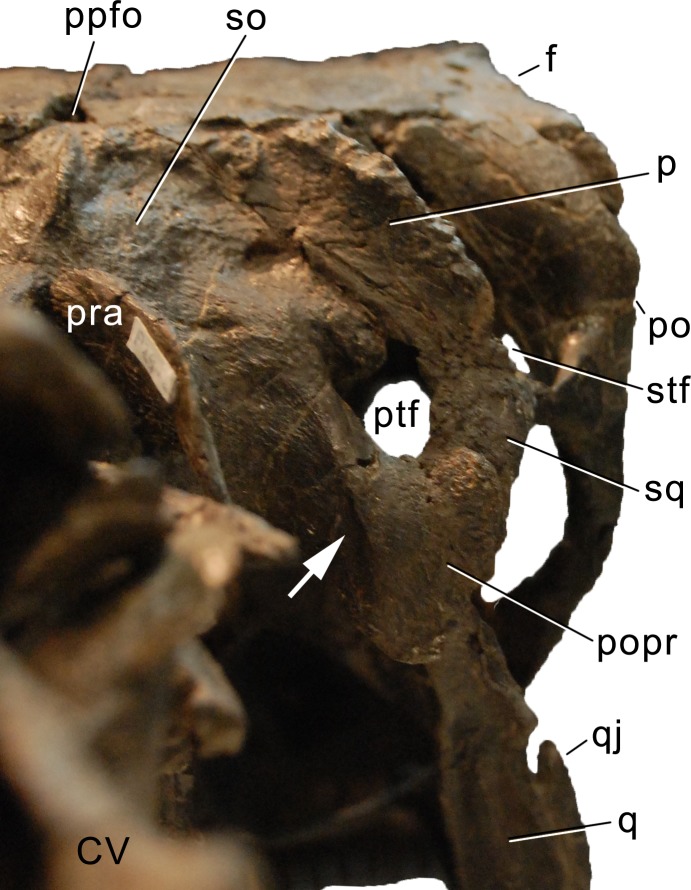
Skull of Kaatedocus siberi SMA 0004 in posterior view.Note the oblique ridge on paroccipital process (arrow, C67-1). Abb.: CV, cervical vertebrae; f, frontal; p, parietal; po, postorbital; popr; paroccipital process; ppfo, postparietal foramen; pra, proatlas; ptf, posttemporal fenestra; q, quadrate; qj, quadratojugal; so, supraoccipital; sq, squamosal; stf, supratemporal fenestra.